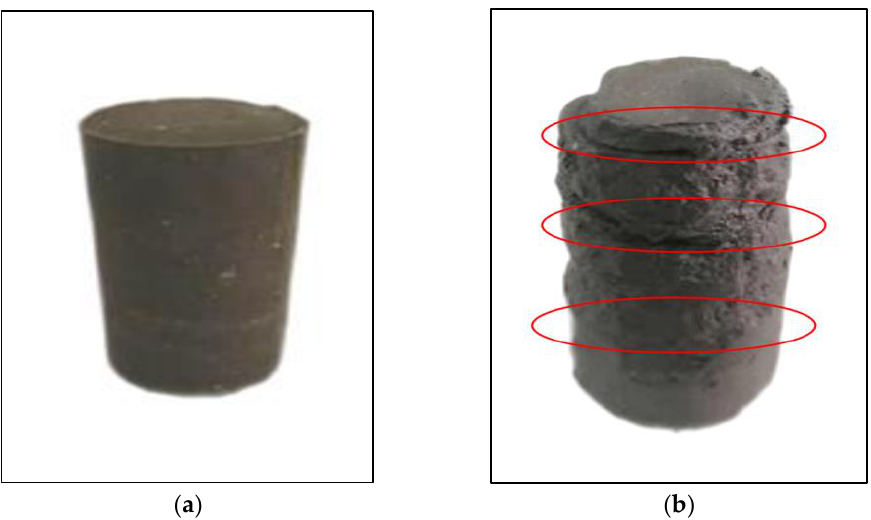
Figure 23. Morphology of the solidified silt with a w g of 2% during dry-wet cycles: ( a ) N dw = 0, ( b ) N dw = 1.